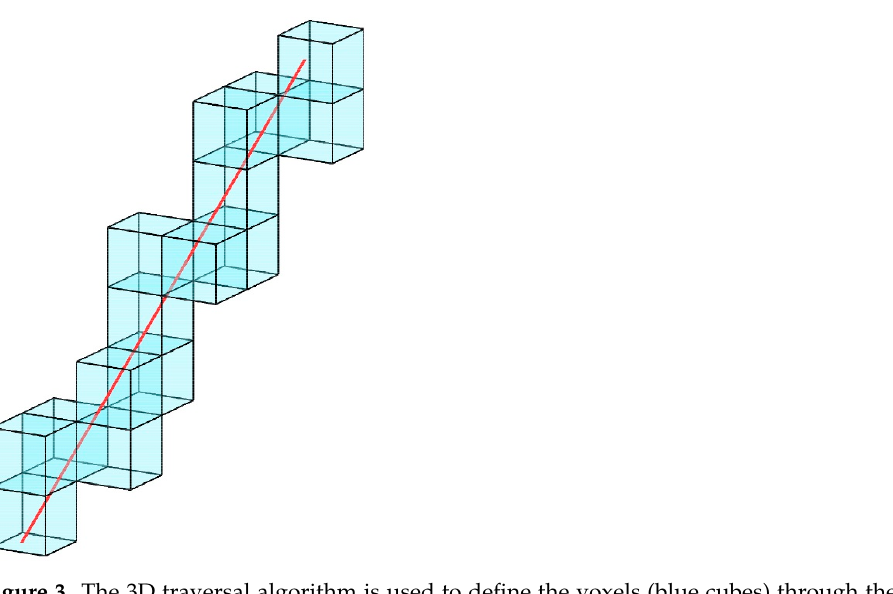
Figure 3. The 3D traversal algorithm is used to define the voxels (blue cubes) through the signal (red